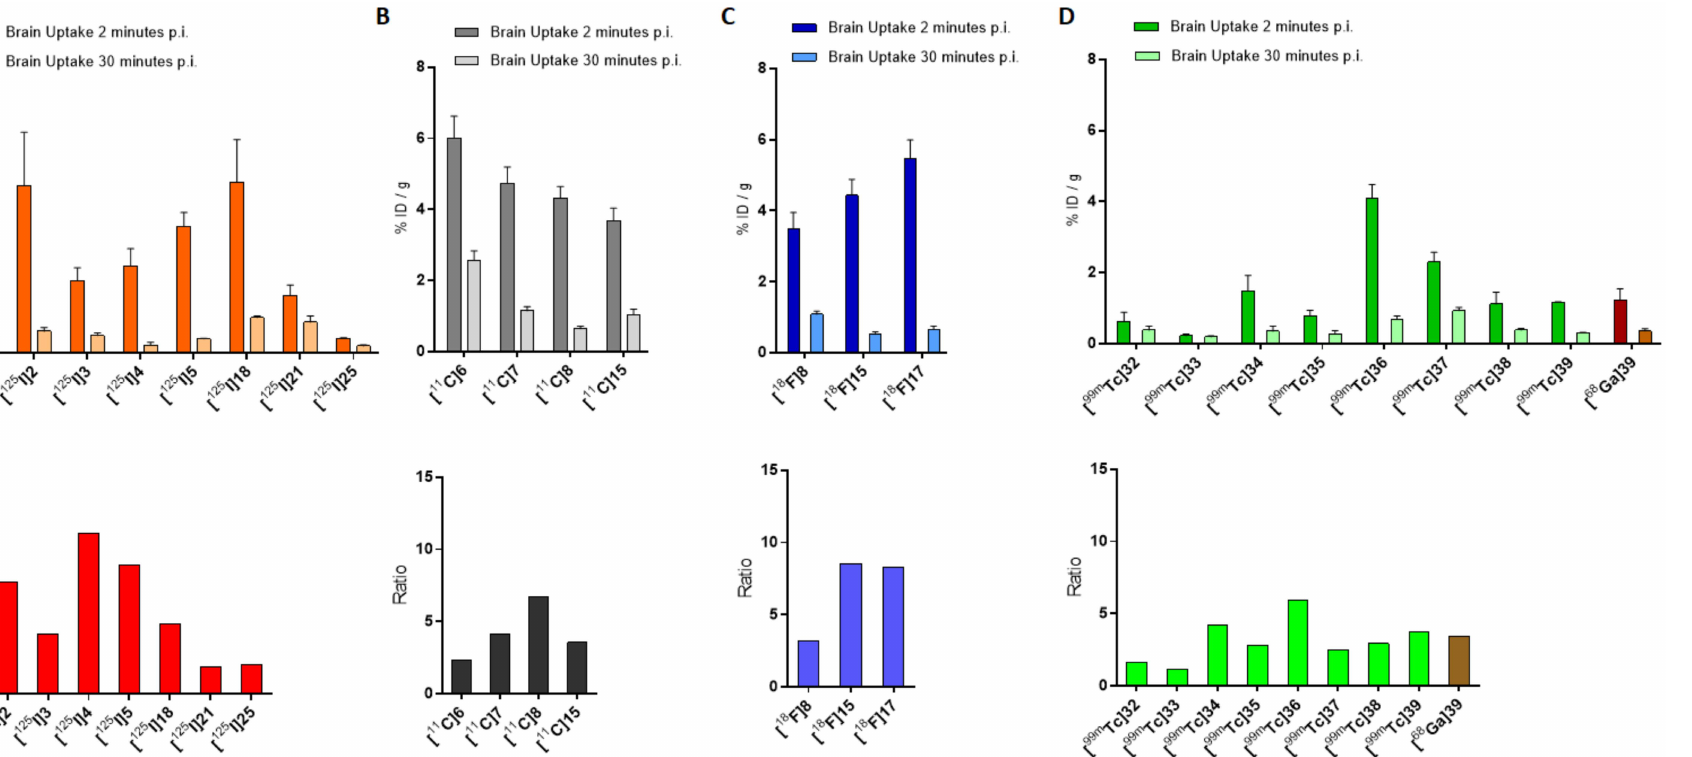
Figure 4. Brain uptakes at 2 and 30 min post injection of [ 125 I]-labeled ( A ), [ 11 C]-labeled ( B ), [ 18 F]-labeled ( C ), [ 99m Tc]- and [ 68 Ga]-labeled ( D ) chalcone derivatives in normal mice and the relative